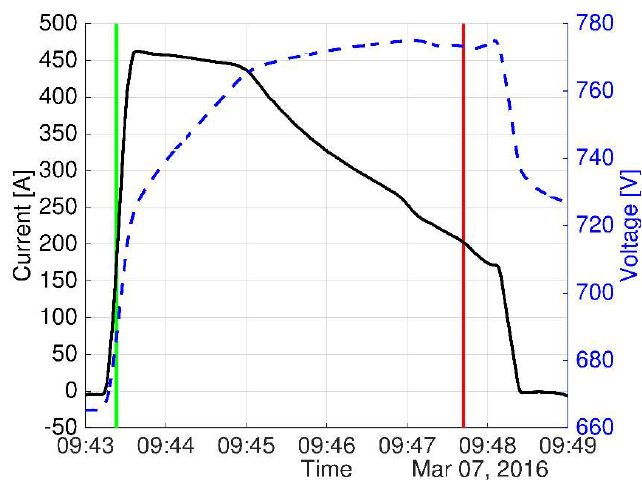
Figure 4. Data parsing of charge cycles. The presented view shows a complete charge cycle. The start and end of a charging event is highlighted with a vertical line. The black line represents the battery current and the blue dashed line represents the battery voltage.